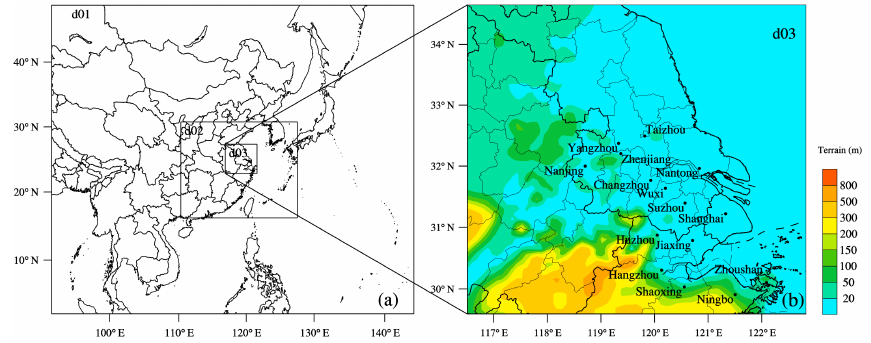
Figure 1. Domain settings, including (a) the three nested modeling domains and (b) the nested domain 3 (d03) with the terrain elevations and the locations of 15 main cities in the YRD